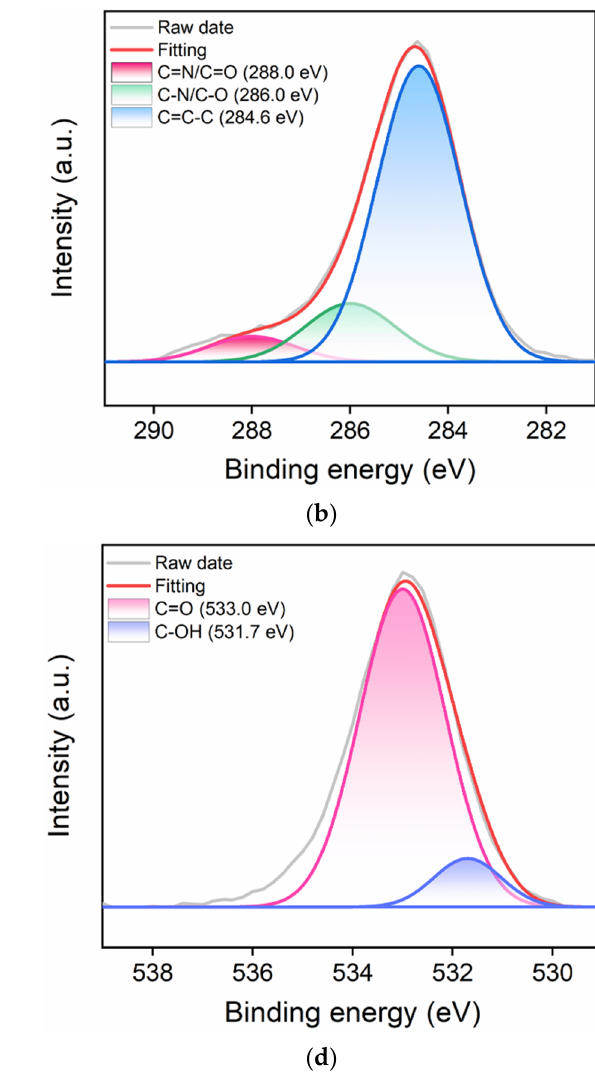
Figure 3. XPS survey spectrum ( a ) and high-resolution C 1s ( b ), N 1s ( c ), and O 1s ( d ) spectra of CDs. Fourier transform infrared spectroscopy (FT-IR) was used to further characterize the surface functional groups of CDs. As shown in Figure 4, peaks at 3406 cm − 1 , 3128 cm − 1 , and 2860 cm − 1 were attributed to the stretching vibration of N-H/O-H, -OH, and C-H groups, respectively. In addition, the peaks at 1628 cm − 1 , 1534 cm − 1 , 1357 cm − 1 , and 1093 cm − 1 were related to the stretching vibrations of C=O, C=C/C=N, C-N, and C-O, respectively. These results proved that there were rich nitrogen and oxygen functional groups on the surface of the